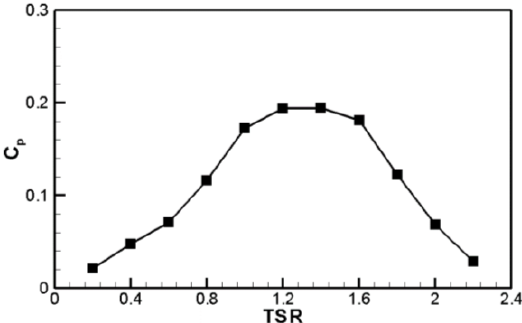
Figure 5. Power coefficient of the turbine versus tip speed ratio.